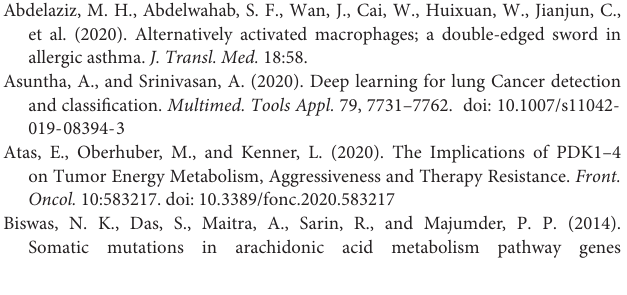
Supplementary Figure 1 | The Kaplan-Meier curves of the 22 TIICs. Red lines represent high expression group, while blue lines represent low expression group. The upper line indicates the higher survival rate, while the lower line indicates the lower survival rate. Among these 22 TIICs, only neutrophils have significant prognostic values in OSCC ( p = 0.031), while the other 21 TIICs doesn’t have significant prognostic values ( p > 0.05). Supplementary Table 1 | The 42 prognosis-related ISGs with p -value less than 0.01, ranked in the ascending order of p -value. Supplementary Table 2 | The 11 risk ISGs with the prognostic values in OSCC, ranked in the ascending order of p -value. Supplementary Table 3 | The C-index values and time-dependent AUC values of 11 prognosis-related ISGs shown in the ROC curves. Supplementary Table 4 | The clinical characteristics of OSCC samples ( n = 317) from TCGA database. Supplementary Table 5 | The clinical characteristics of OSCC samples ( n = 40) from ICGC database.